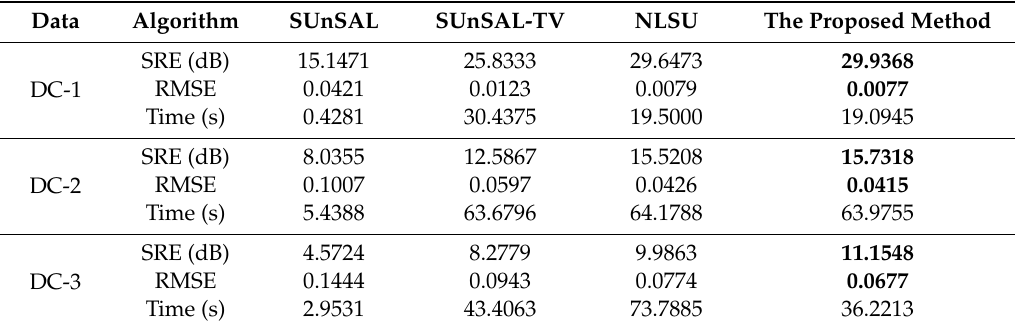
Table 1. Performance comparison for the di ff erent methods with the three simulated data cubes.